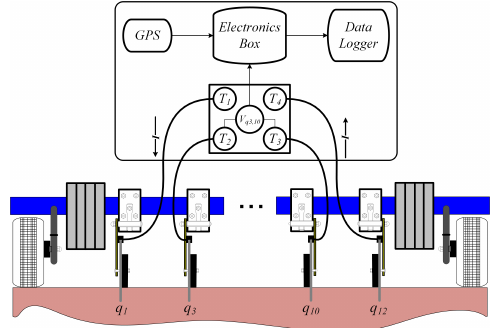
Figure 11. Electronic system of